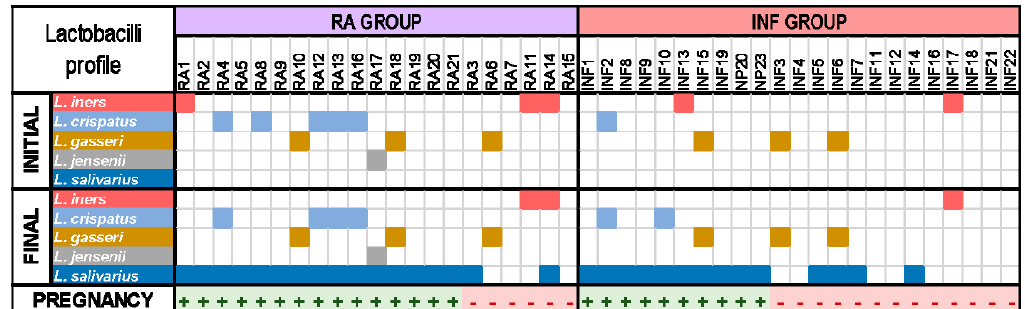
Figure 7. Changes in the profile of dominant Lactobacillus species in CVL samples from women with a history of repetitive abortion (RA group) and women with infertility of unknown origin (INF group) after the probiotic intervention with L. salivarius CECT5713. The outcome is indicated in the last file: +, successful full-term pregnancy and -, no pregnancy. The presence of isolates from a given species is indicated by a colored square.